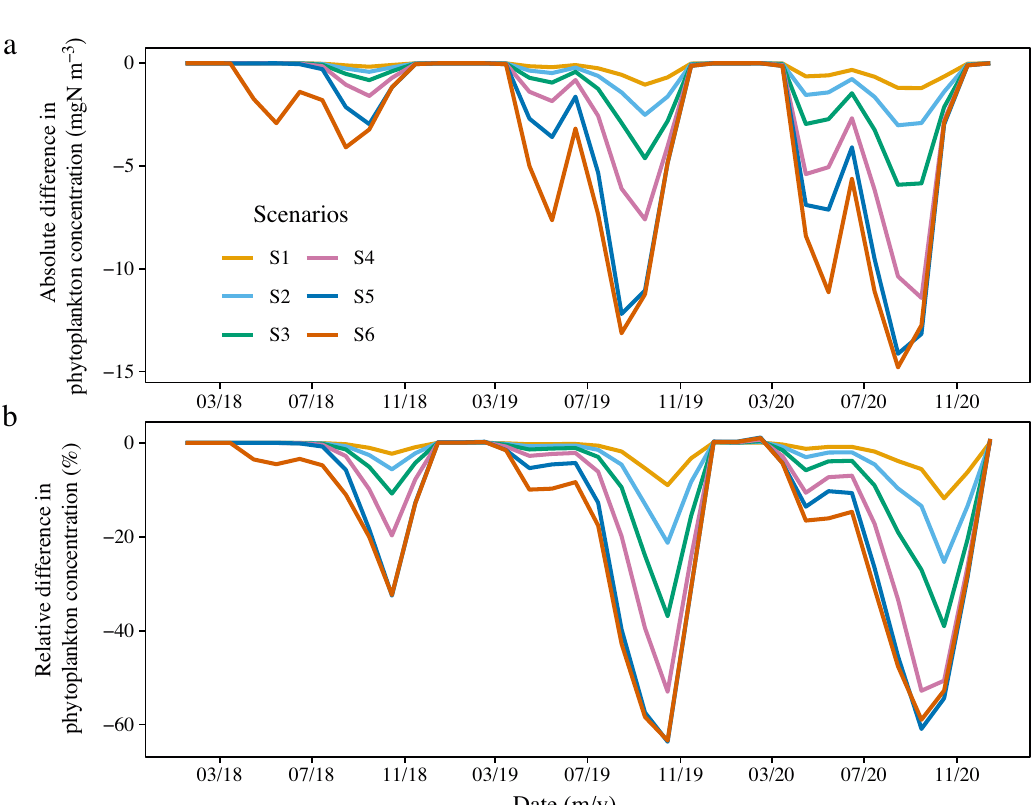
Fig. 9. Time series of (a) absolute and (b) relative phytoplankton concentration changes in scenarios 1 through 6, relative to the reference scenario